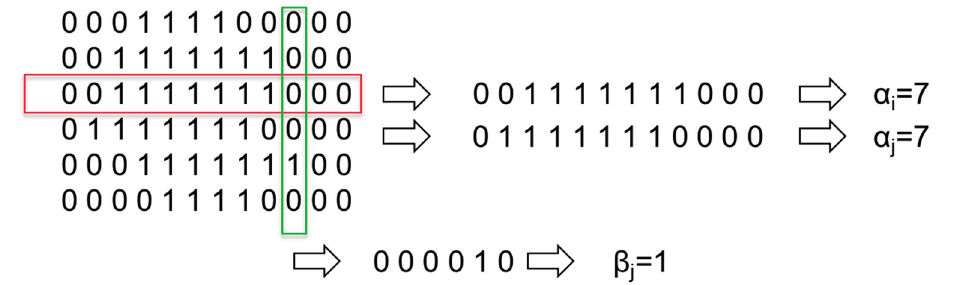
Figure 9. Line-based Image Coding.